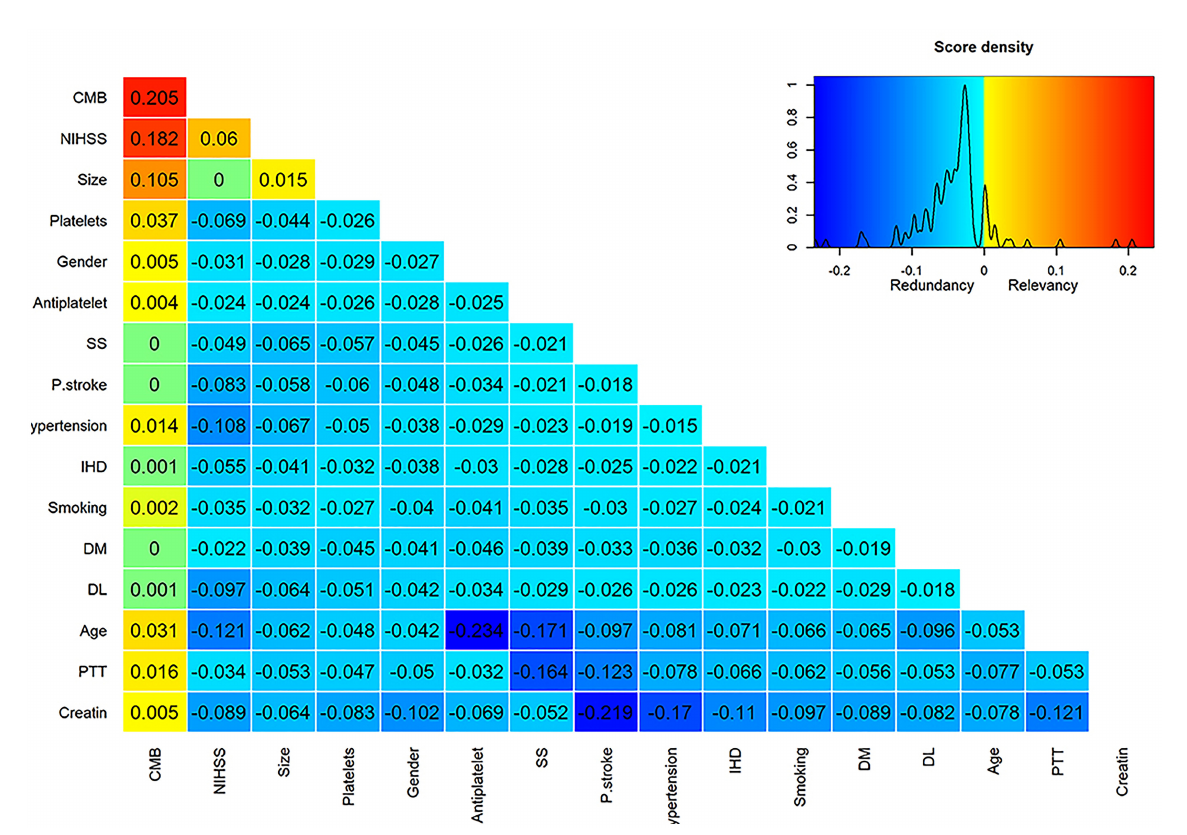
FIGURE1 Score matrix of all studied variables assessed by the mRMRe (minimum redundancy maximum relevance) algorithm provided by the varrank R package. The first column represents the relevance scores of different variables assessed by the mutual information algorithm relative to the HT incidence and ranked in a descending manner. Subsequent columns represent the difference between the relevance and redundancy scores of each variable after adding it to the previously selected variable. Positive scores indicate higher relevance than redundancy scores and were color-coded by a scale from yellow to red, whereas negative scores indicate higher redundancy than relevance scores and were color-coded by a scale from aqua to deep blue. Zero scores were colored